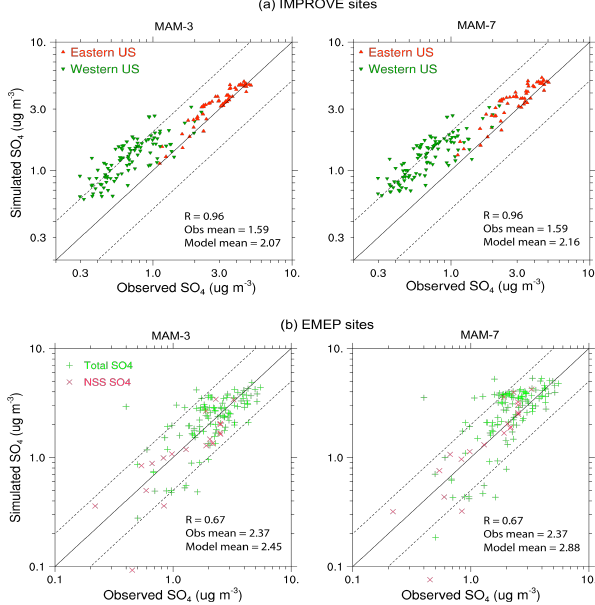
Figure 8. Observed and simulated annual-average SO 2 mixing ratios at IMPROVE and EMEP network sites. Observations are for site-available years between 1990-2005 for IMPROVE sites and 1995-2005 for EMEP sites. Simulated values for MAM3 (left) and MAM7 (right) are from model lowest layer. Top: IMPROVE network, Eastern U.S. sites are east of 97 W longitude. Bottom: EMEP network.